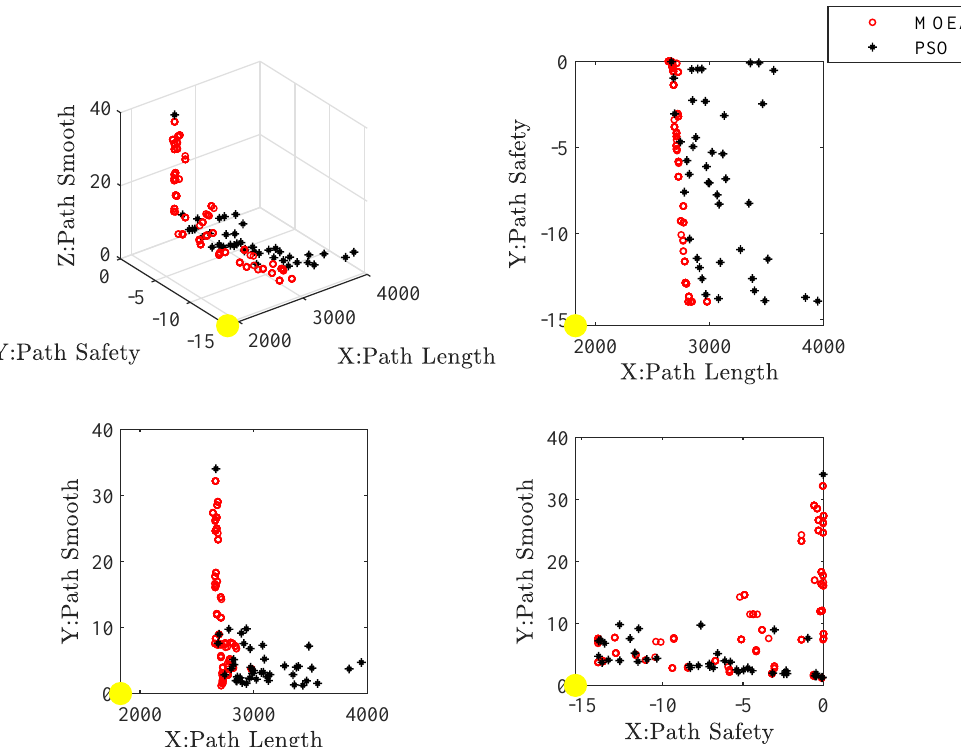
Figure 11. Approximate Pareto fronts for Figure 8C: MOEA vs. PSO.